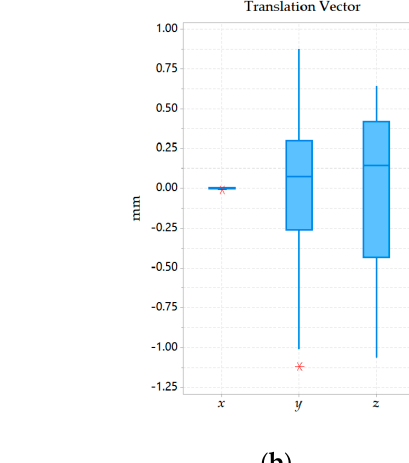
Figure 14. Box plot of the Euler angles and translation vector minus the mean in the first set of experiments: ( a ) Distribution of Euler angles; ( b ) Distribution of translation vector.